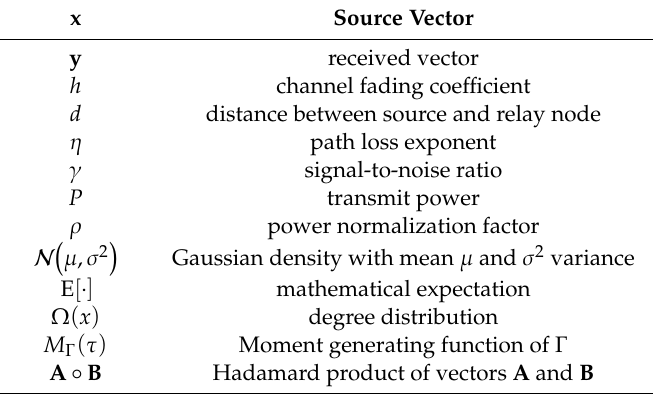
Table A1. Summarization of Key Variables and Notations.